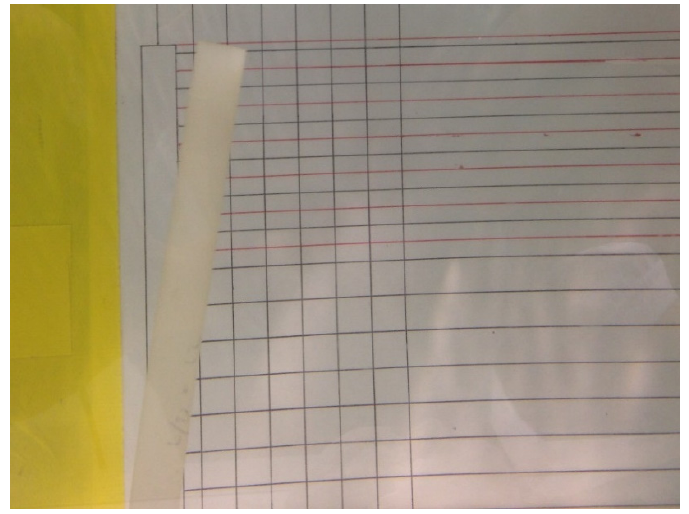
Figure 7. EVA flexible cylinders with AR = 12 and Re = 6000.